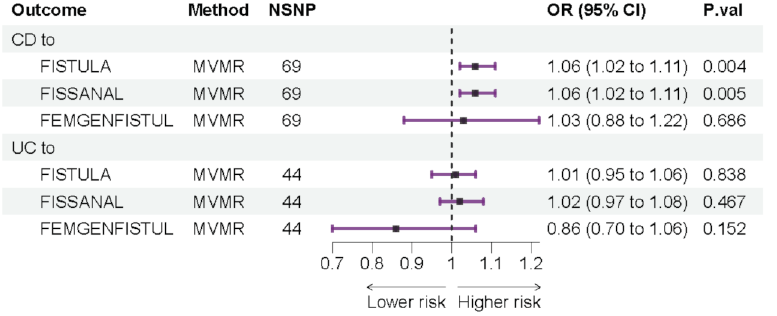
Figure 3. Multivariable Mendelian randomization (MVMR) results. Causal estimation of IBD subtype effects on fistulas (IBD: inflammatory bowel disease; UC: ulcerative colitis, CD: Crohn’s disease; FISTULA: colonic or urogenital fistula; FISSANAL: fissure and fistula of anal and rectal regions; FEMGENFISTUL: fistula involving female genital tract; NSNP: the number of single nucleotide polymorphisms used in MR analysis; OR: odds ratio; CI: confidence interval).